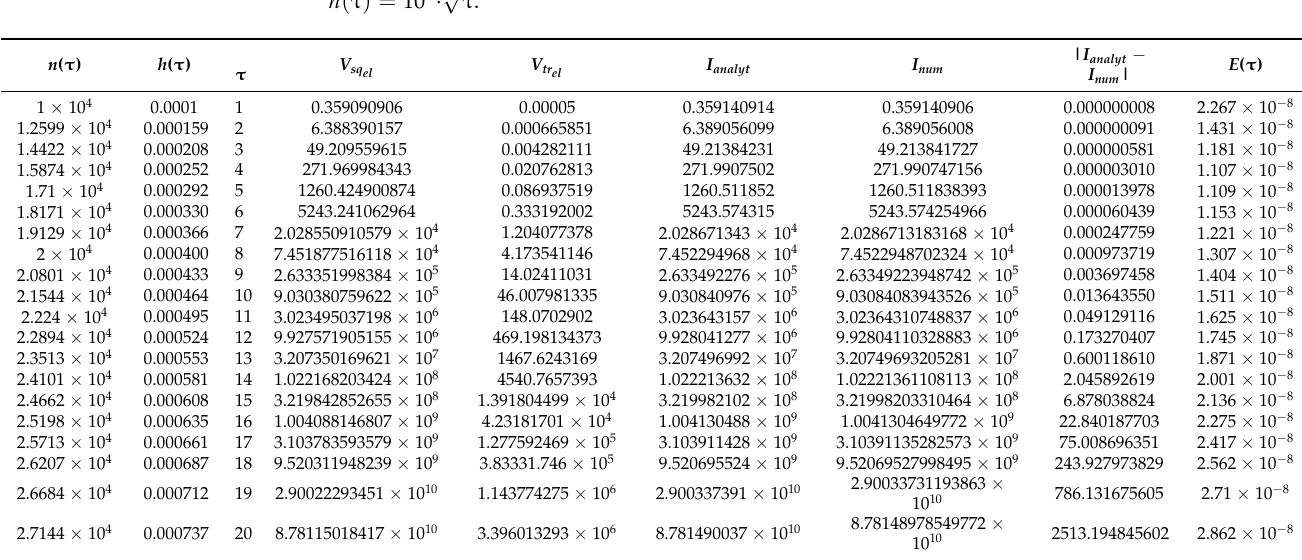
Table 7. Calculation of integral